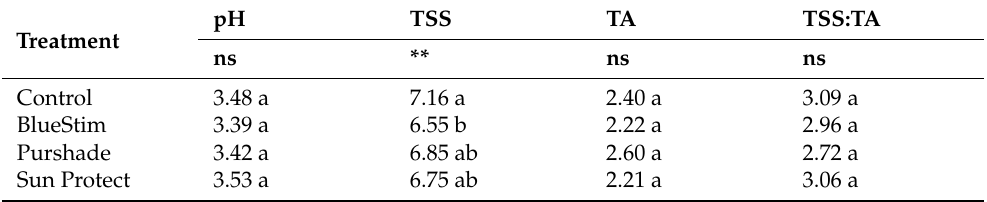
Table 3. Alleviating products’ effect on kiwifruit juice pH, total soluble solids (TSS) ( ◦ Brix), titratable acidity (TA) (g citric acid 100 g − 1 fresh weight), and the ratio of total soluble solids: titratable acidity (TSS:TA) at harvest.